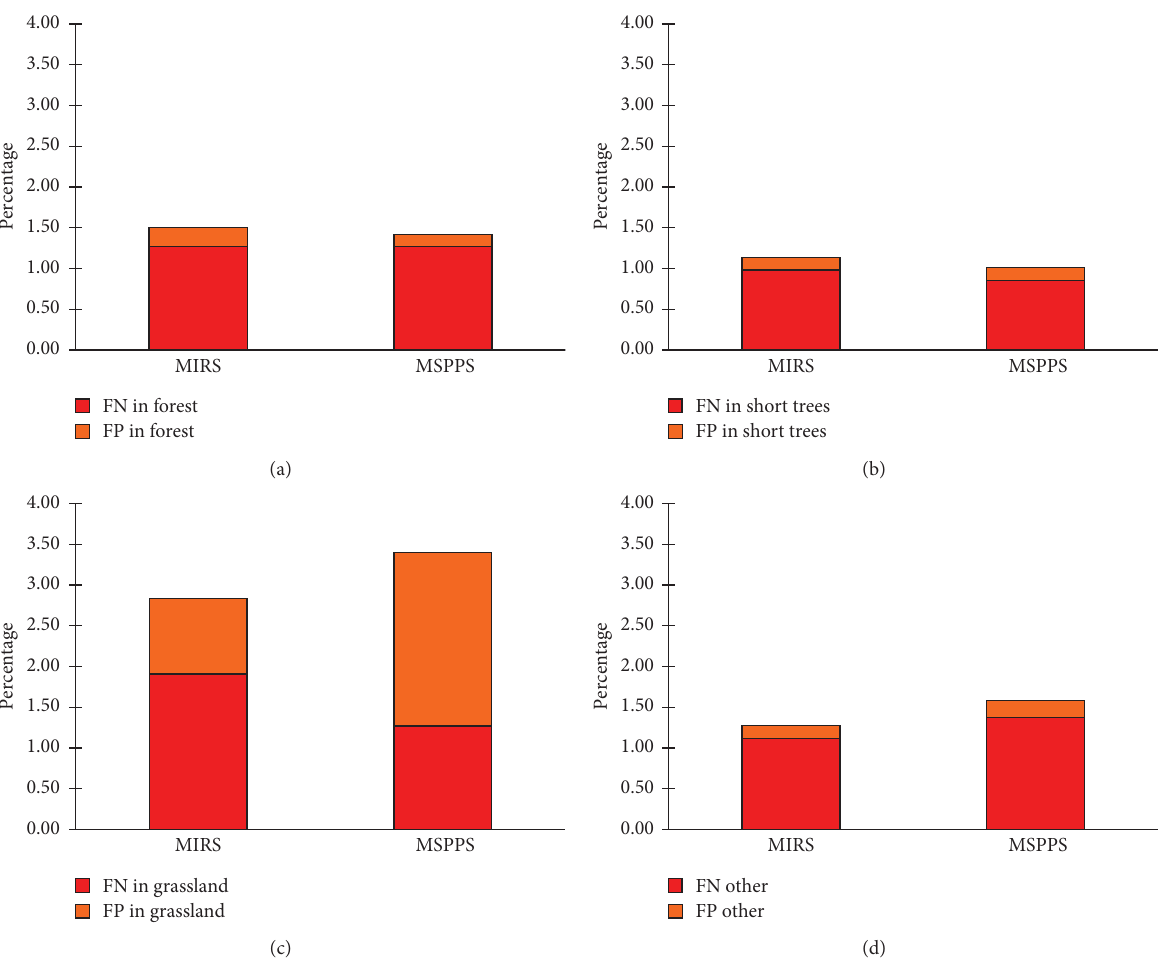
Figure 11: Percentages of false negatives (FN) and false positives (FP) by land cover type: (a) Forest, (b) Short Trees, (c) Grassland, and (d)